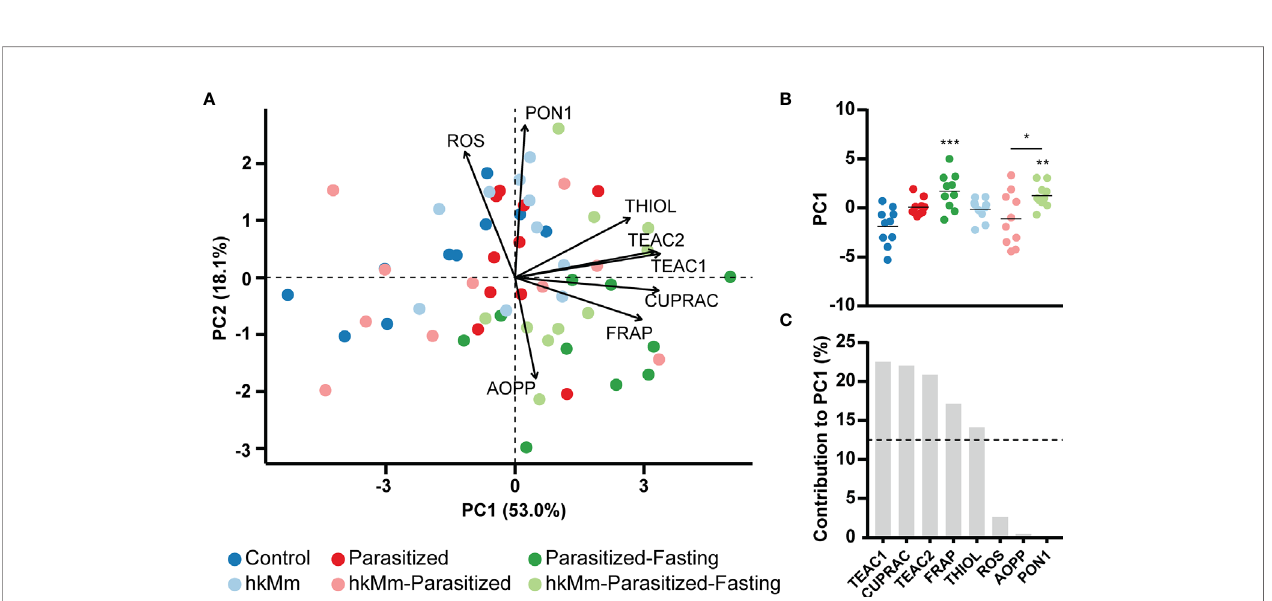
FIGURE 4 | Oxidative stress analysis at week 3 post-infection. (A) PCA based on mediator concentration in serum. (B) PC1 scores, each circle represents an animal and lines are means; ANOVA p -value=0.0001, Holm-Sidak ’ s multiple comparisons test (*p < 0.05, **p < 0.01, ***p < 0.001). (C) Mediators contribution to PC1. hkMm, heat-killed M. manresensis ; TEAC, trolox equivalent antioxidant capacity; CUPRAC, cupric reducing antioxidant capacity; FRAP, ferric reducing antioxidant power; PON1, paraoxonase 1; ROS, reactive oxygen species; AOPP, advanced oxidation protein